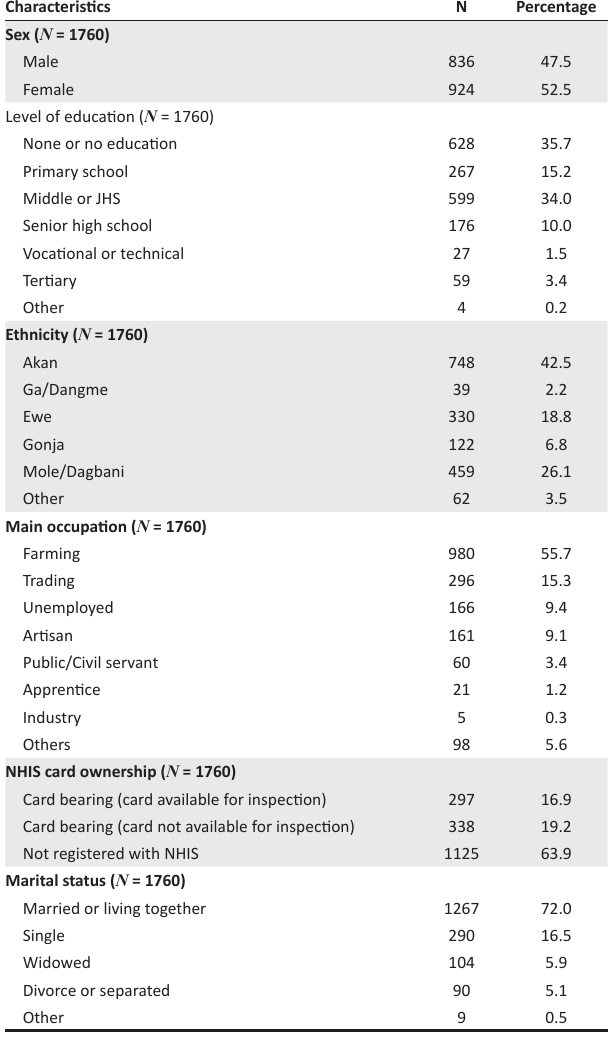
TABLE 1: Demographic characteristics of household survey participants.